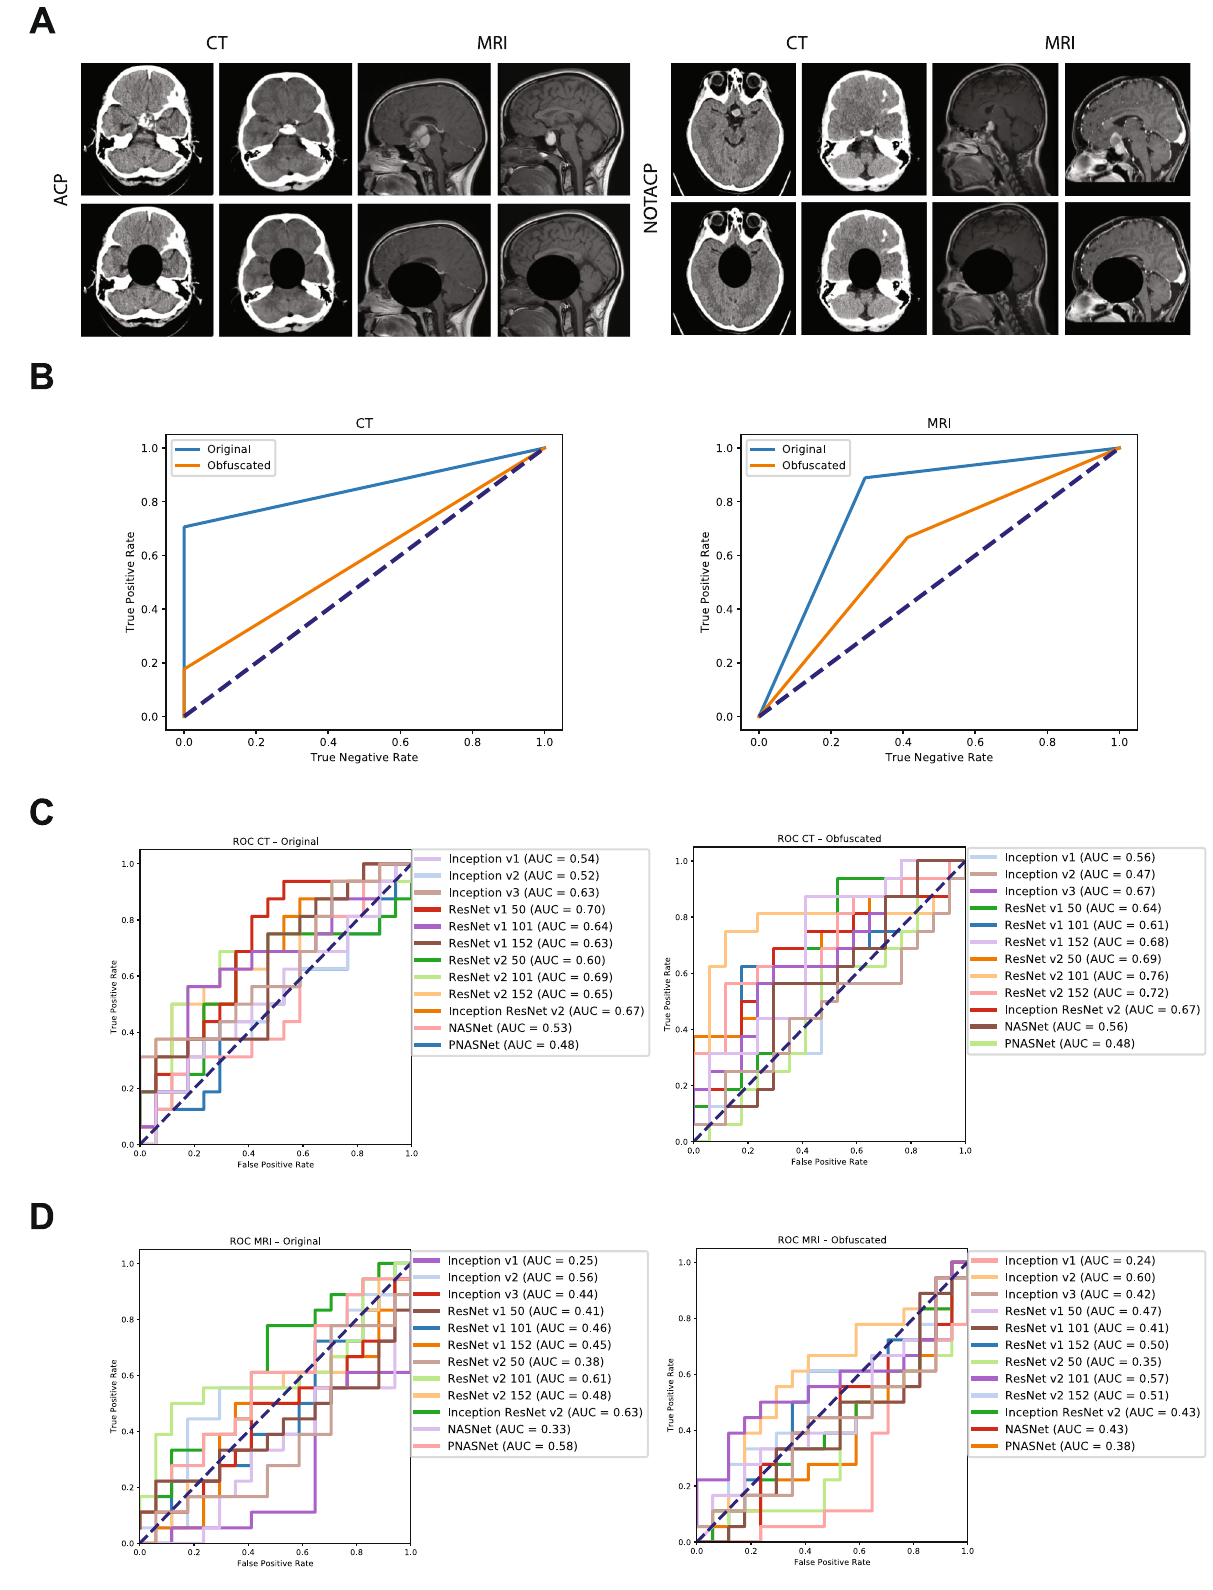
Figure 5. Pituitary obfuscation reveals latent features exist outside canonical ROI for CT scans. ( A ) Example original and obfuscated images for both data classes and both imaging modalities. ( B ) ROC curves for networks trained on obfuscated and original data; original data was ‘Augmented ( N = 1000 )’ variant. ( C ) Baseline ROC curves for all twelve networks trained on original (left) and obfuscated (right) CT images. ( D ) Baseline ROC curves for all twelve networks trained on original (left) and obfuscated (right) MRI